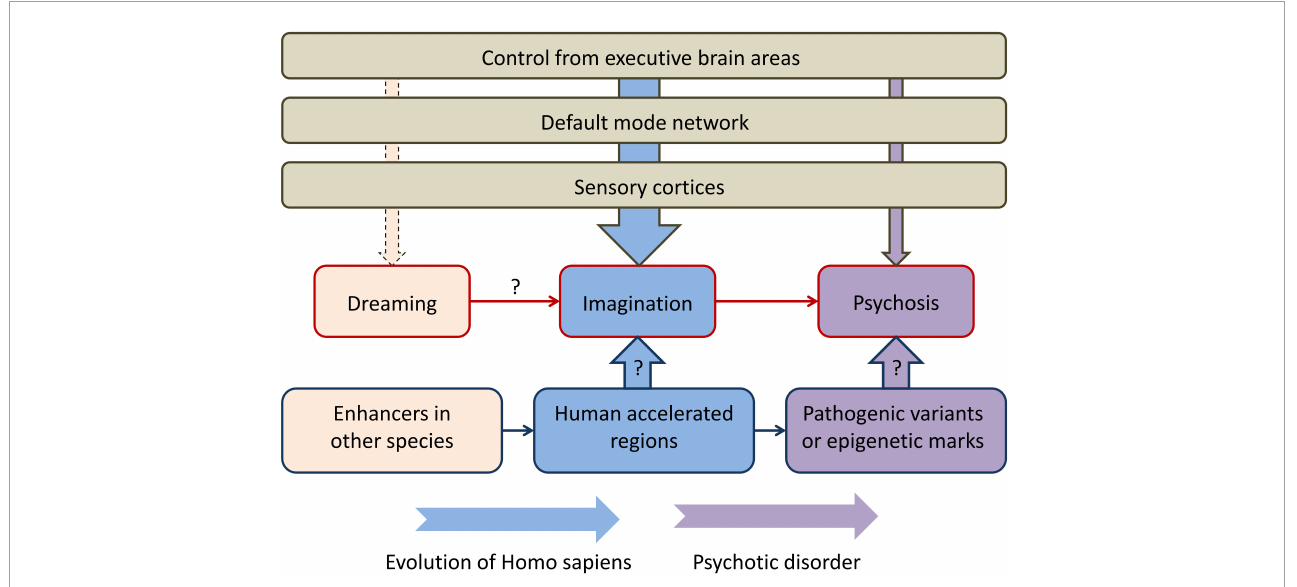
FIGURE1 The perspective described in the present article, connecting rapid eye movement dreaming, imagination, and primary psychosis in the context of human brain evolution. “Dreaming” refers to rapid eye movement dreaming and “psychosis” refers to primary psychosis. Higher-order executive brain areas, such as the lateral prefrontal cortex, control the activity of the default mode network and sensory cortices and have different degrees of control over dreaming, imagination, and psychosis. Human accelerated regions could be one of the main genomic components that determine both evolutionary transformations and the pathogenesis of primary psychosis. Arrows with question marks indicate currently limited empirical